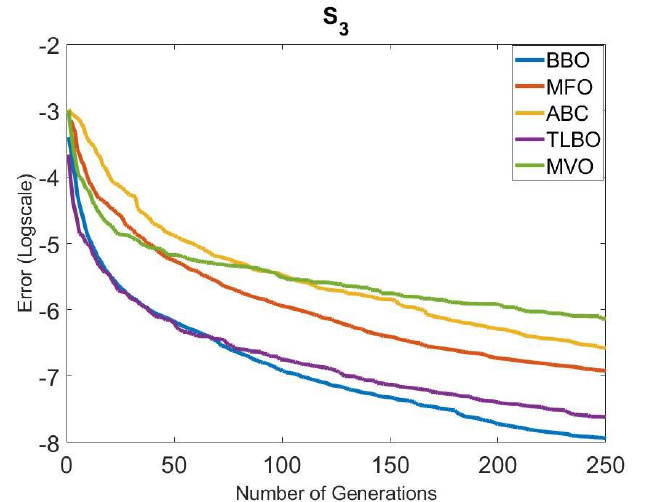
Figure 5. Comparison of the convergence of the metaheuristic algorithms in Group 1 for S 2 .